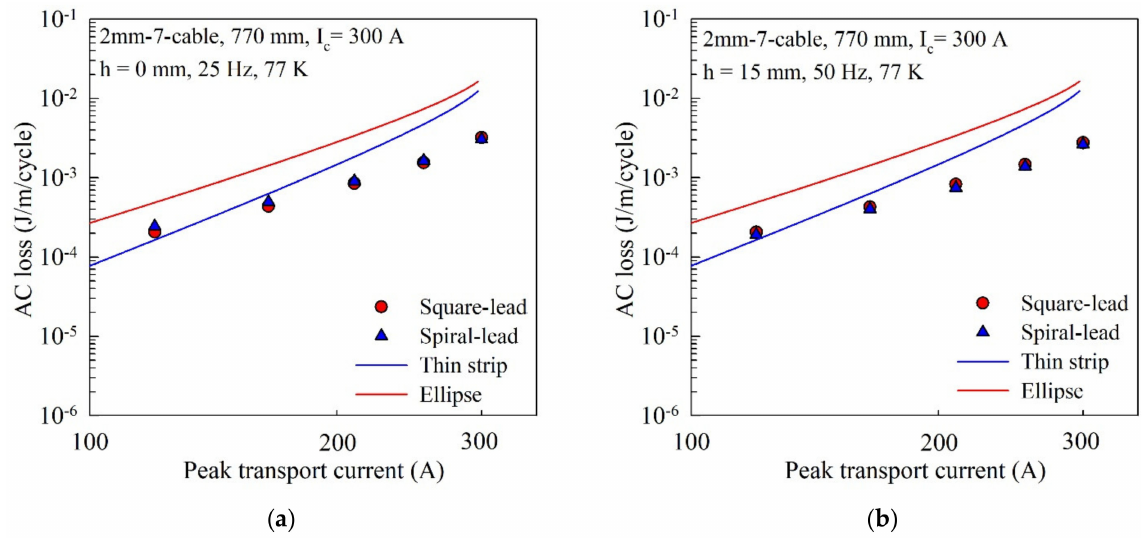
Figure 5. Comparison of AC loss of 2 mm cable under two voltage − lead arrangements. ( a ) AC loss values when the distance between the voltage − leads and the cable sample is 0 mm and the frequency is 25 Hz; ( b ) AC loss values when the distance between the voltage − leads and the cable sample is 15 mm and the frequency is 50 Hz.